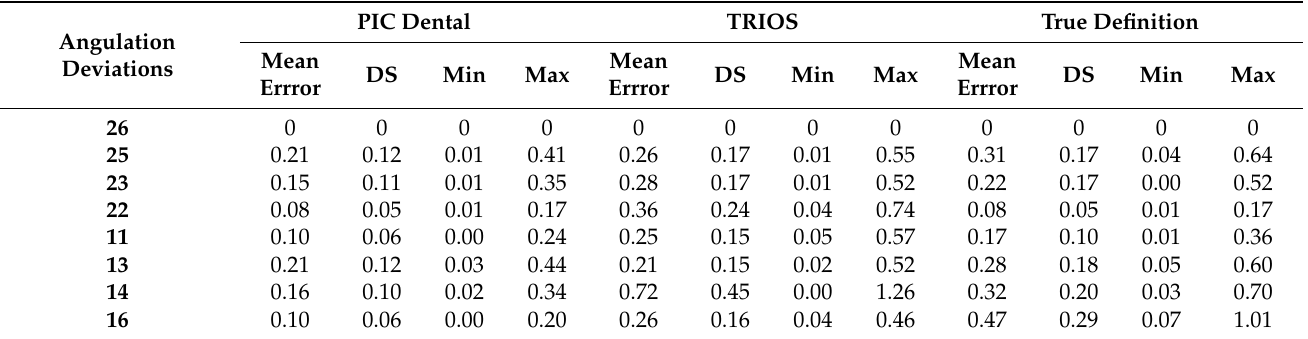
Table 5. Descriptive statistics for each of seven relative angulations (degrees) of maxillary arch obtained with the three evaluated systems.